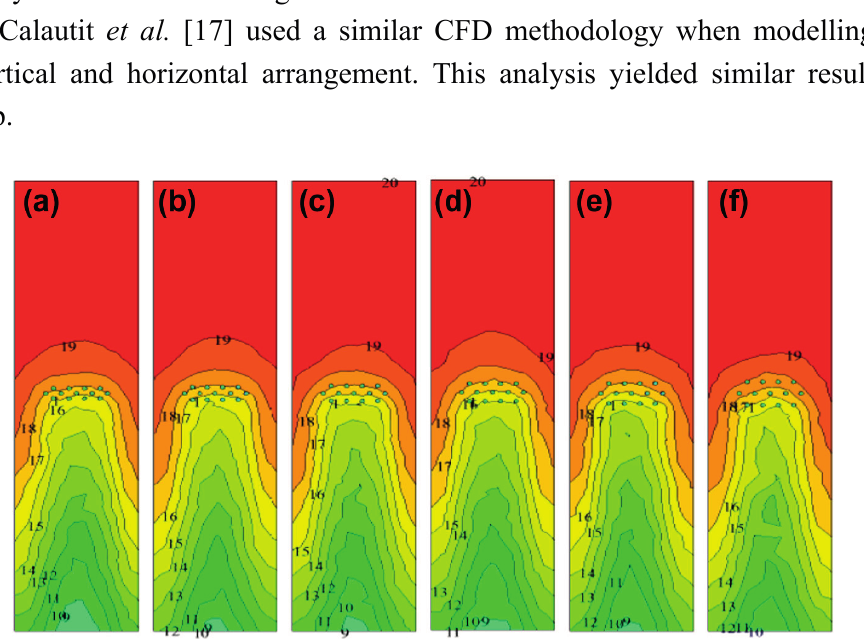
Figure 3. Effect of different pitch spacing on the temperature pro fi le ( a ) 0.020 m ( b ) 0.025 m ( c ) 0.030 m ( d ) 0.035 m ( e ) 0.040 m ( f ) 0.045 m